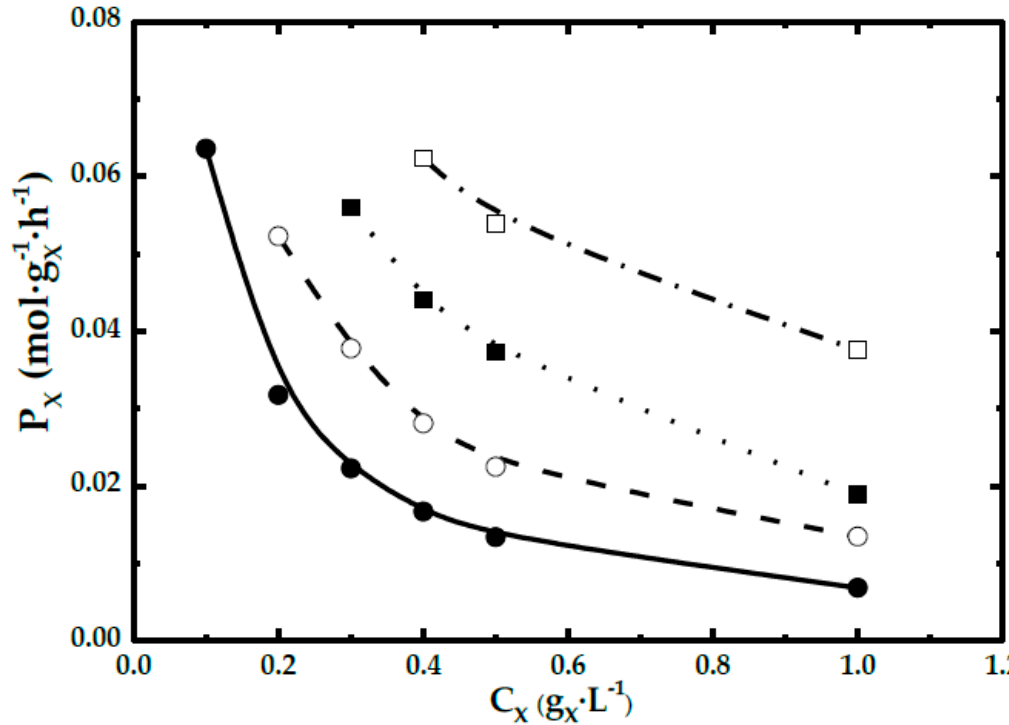
Figure 5. Productivity results corresponding to each biomass concentration employed for shake flask runs: 100 rpm ( ● ), 200 rpm ( ○ ), 300 rpm ( ■ ), and 400 rpm ( □ ).